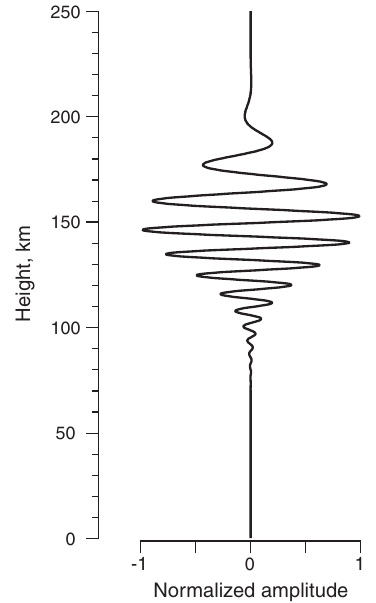
Figure 5. Waveform of electron density perturbation due to upward- propagating acoustic